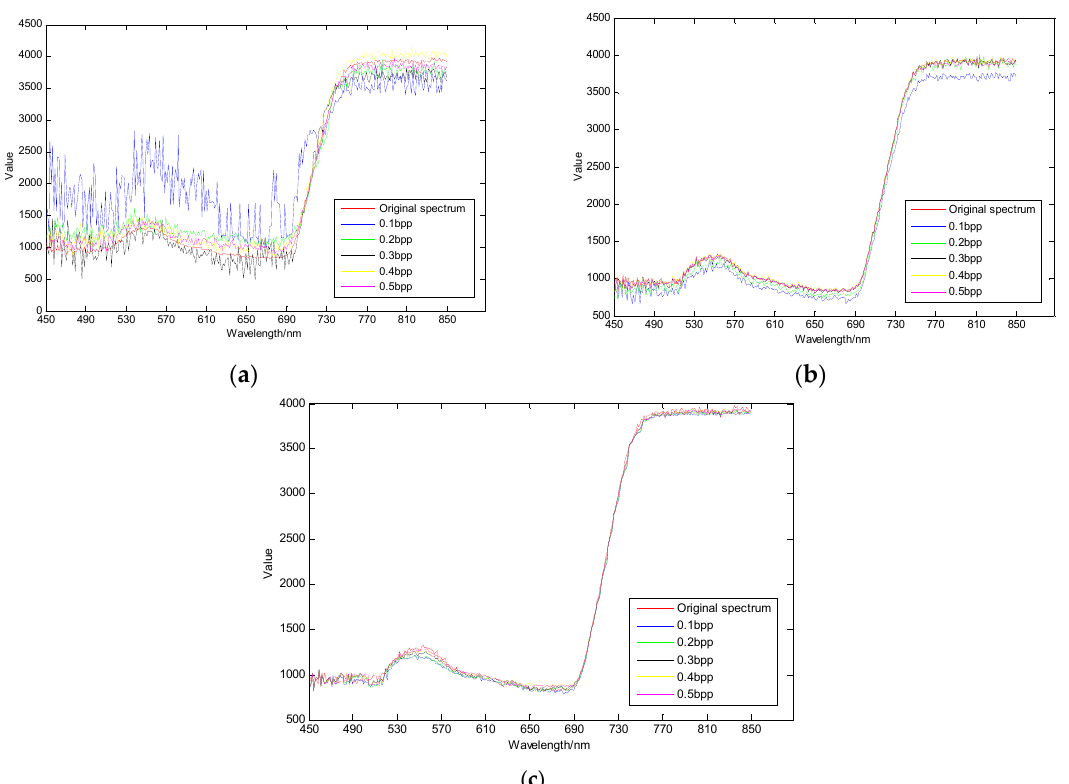
Figure 11. Comparison of reconstructed spectral curves of ROI2. ( a ) OMP; ( b ) GPSR; ( c ) AGDCS.